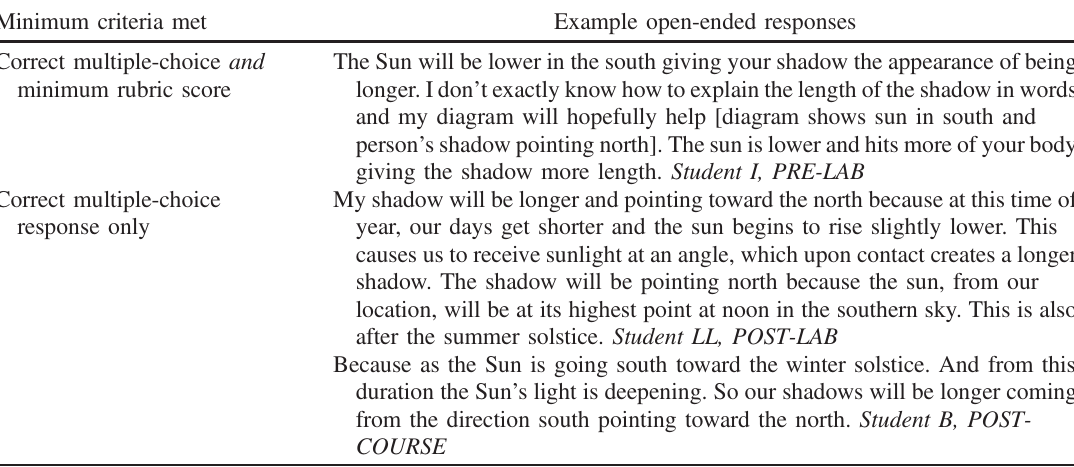
TABLE IV. Example open-ended responses given for the assessment about the changing length and direction of a shadow over a two week